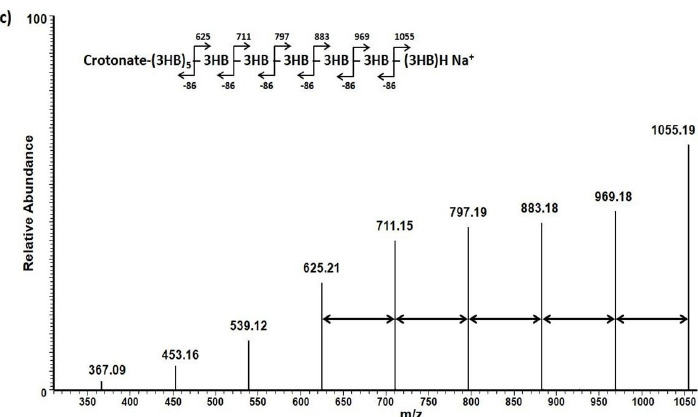
Figure 3. ESI-MS (positive-ion mode) of poly(3-hydroxybutyrate) obtained via AROP of BL initiated with sodium phenoxide; series a n —sodium adducts of α -hydroxy- ω -carboxylate-PHB chains (ESI-MS 2 fragmentation spectrum (positive-ion mode) of corresponding parent ion m/z 1073 is shown in Figure 3b); series b n —sodium adducts of α -crotonate- ω -carboxylate-PHB chains (ESI-MS 2 fragmentation spectrum (positive-ion mode) of corresponding parent ion m/z 1055 is shown in Figure 3c), series c n — α -phenoxy- ω -carboxylate-PHB chains (ESI-MS 2 fragmentation spectrum (positive-ion mode) of corresponding parent ion m/z 1063 is shown in Figure 3a). Index n corresponds to the number of PHB repeating units.